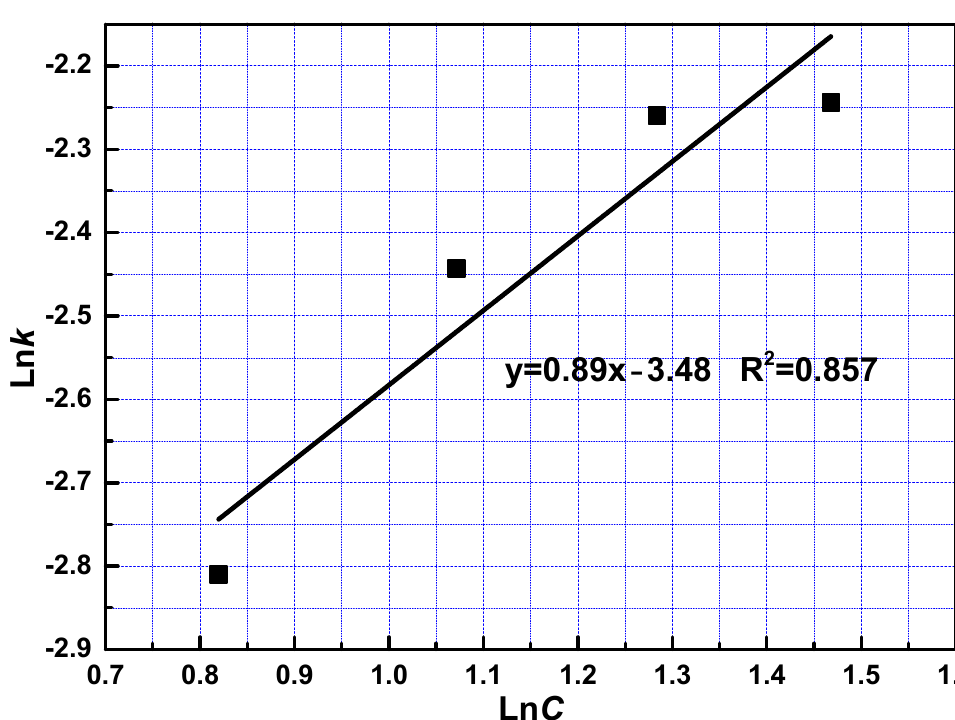
Figure 7. Arrhenius plot for leaching of REEs from phosphate ore at fast reaction stage.